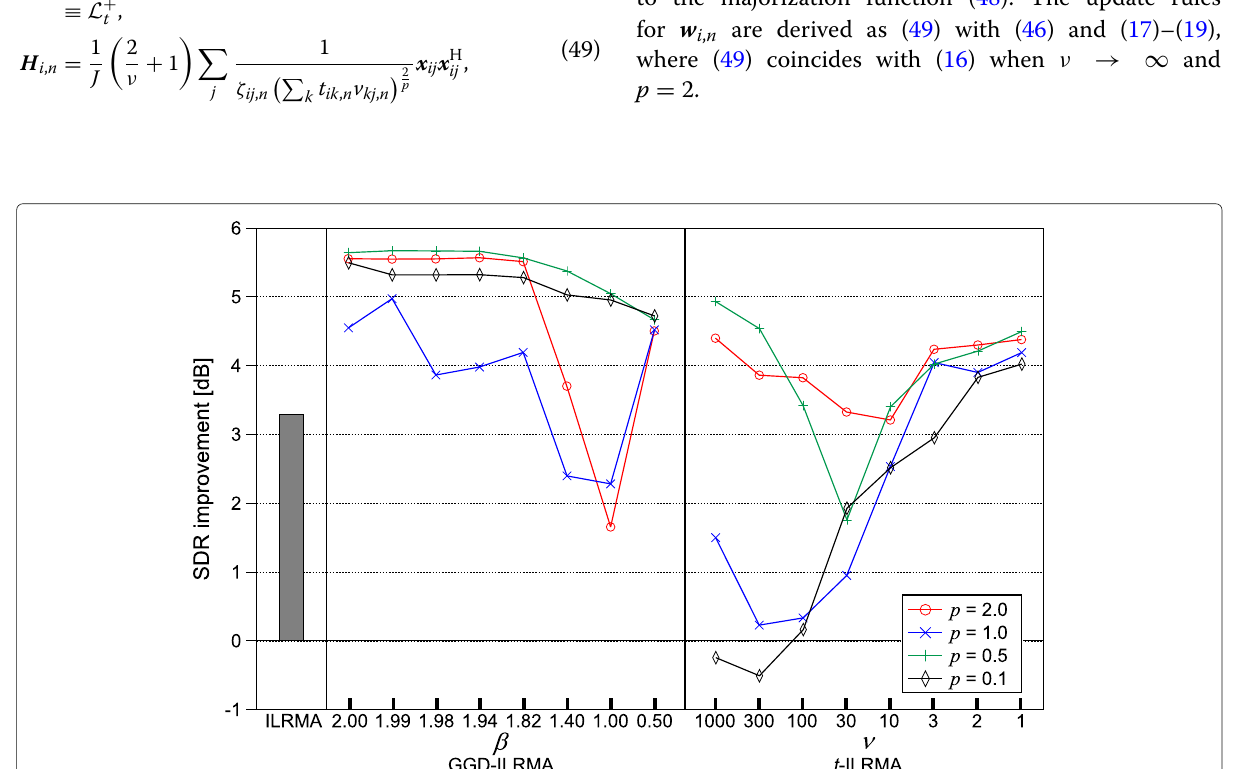
Fig. 21 Average SDR improvements of Music 3 with E2A_2 signal using parameter